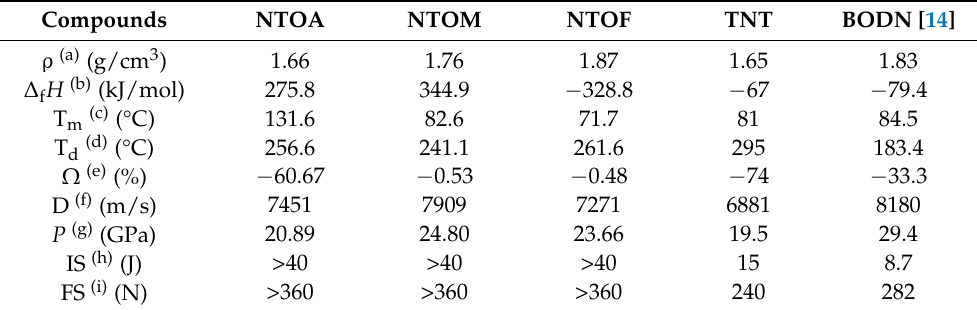
Table 2. Physicochemical properties and detonation performances of NTOA, NTOM, NTOF, TNT and BODN.